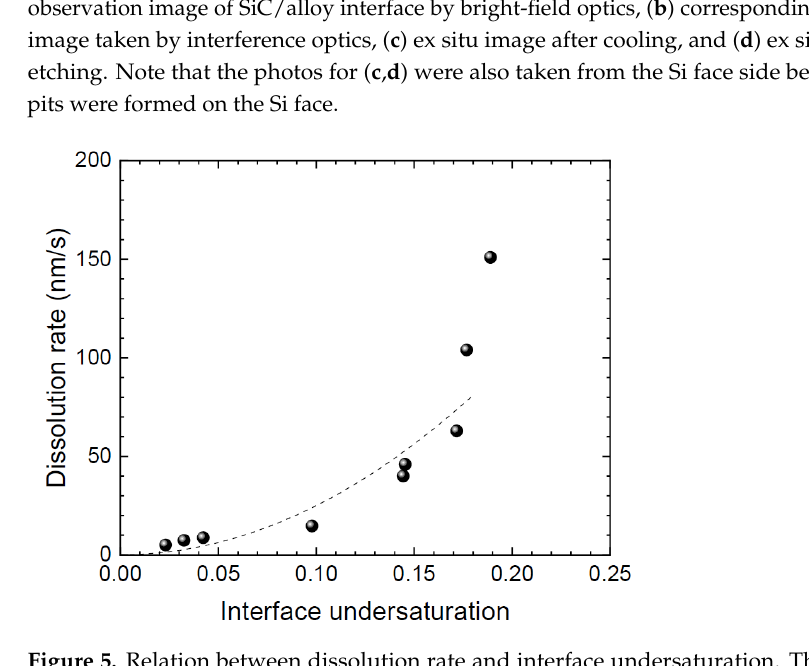
Figure 5. Relation between dissolution rate and interface undersaturation. The dashed curve is a guide to the eye, indicating y = ax 2 .